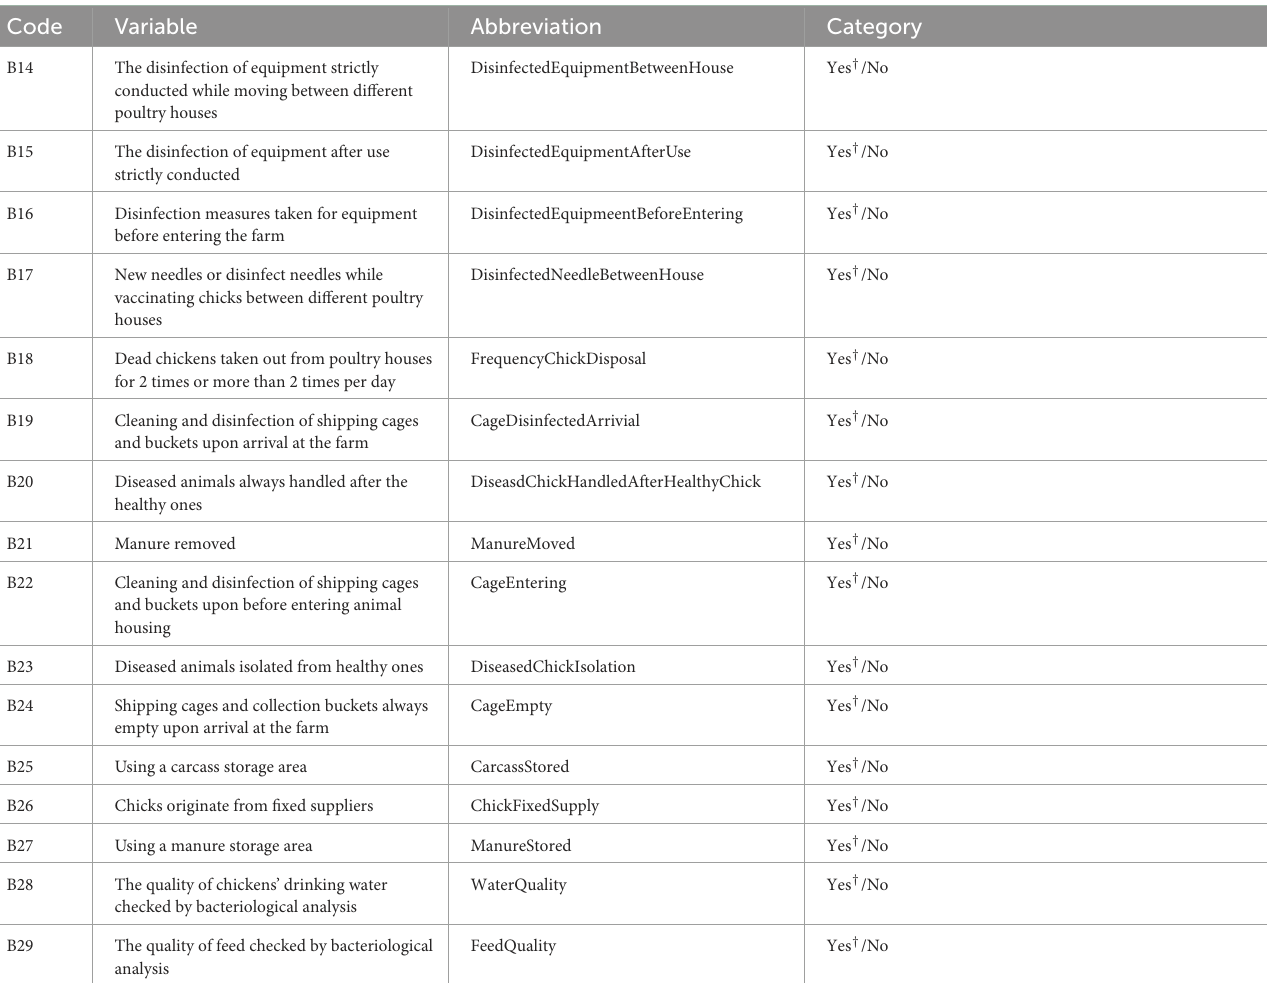
DisinfectedChickHouse” had the fewest farmers who